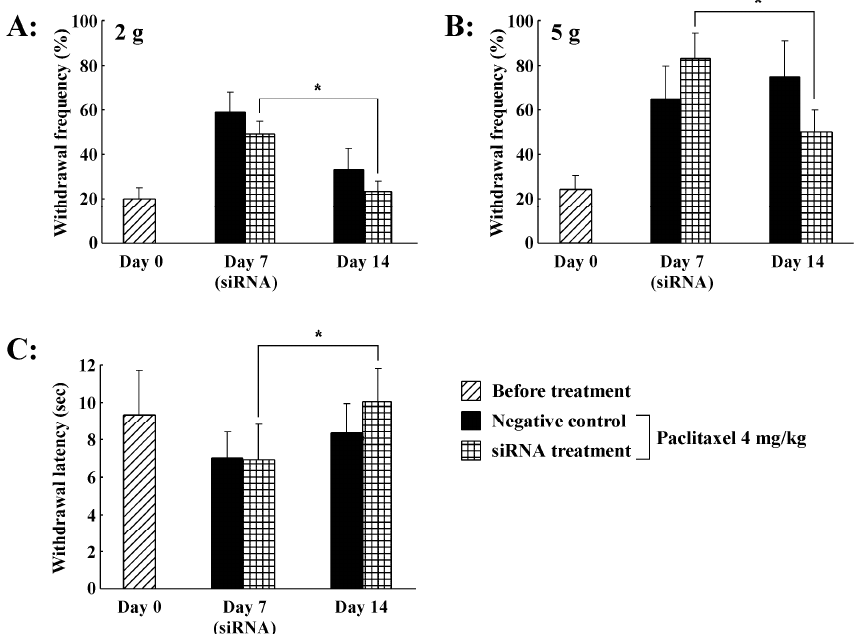
Figure 5. Confirmation of TRPV1 small interfering RNA (siRNA) effects on TRPV1 protein levels in the spinal cord. TRPV1 siRNA reduced TRPV1 protein expression. TRPV1 and β -actin protein in the spinal cord at day 14 after paclitaxel treatment (4 mg/kg) were measured. Treatment with TRPV1 siRNA significantly reduced TRPV1 protein levels compared to the paclitaxel treatment group. The top panel shows a representative Western blot in which TRPV1 and protein expression was normalized to β -actin expression as expressed relative to the paclitaxel (4 mg/kg) treatment group. The histogram shows the effect of paclitaxel treatment and TRPV1 siRNA treatment on relative amounts of TRPV1 protein expression. Data are the mean ± SEM of n = 5–6 rats. * p < 0.05 relative to the paclitaxel group.